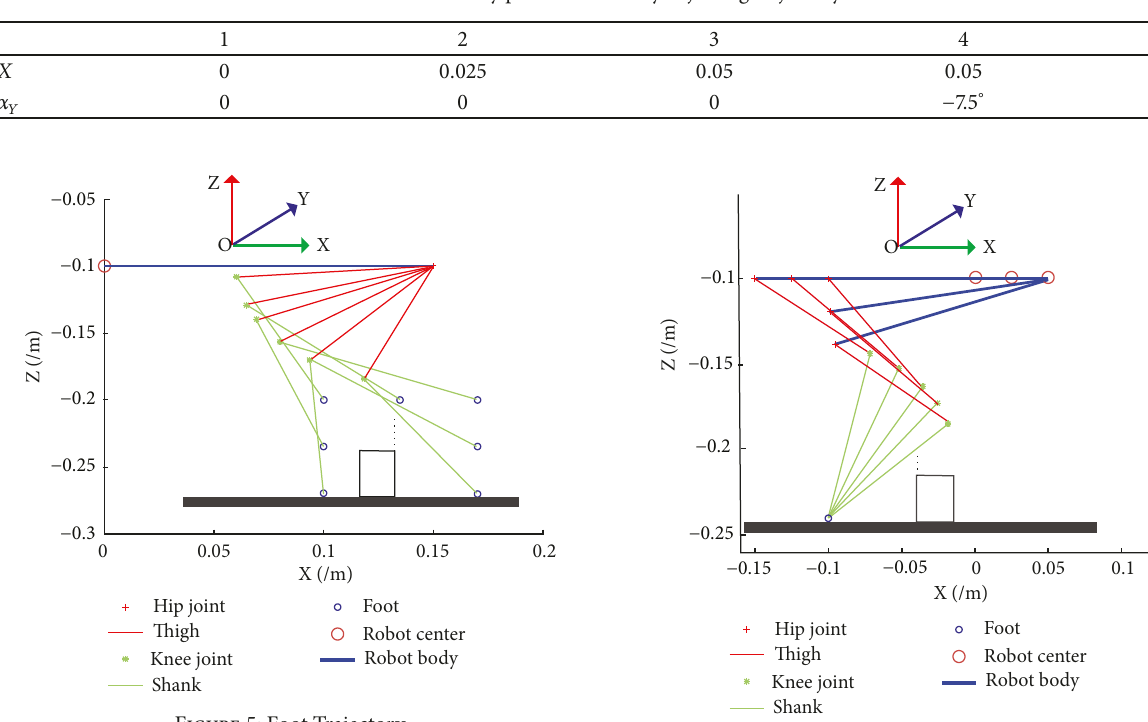
Table 2: Key poses in the body adjusting trajectory.